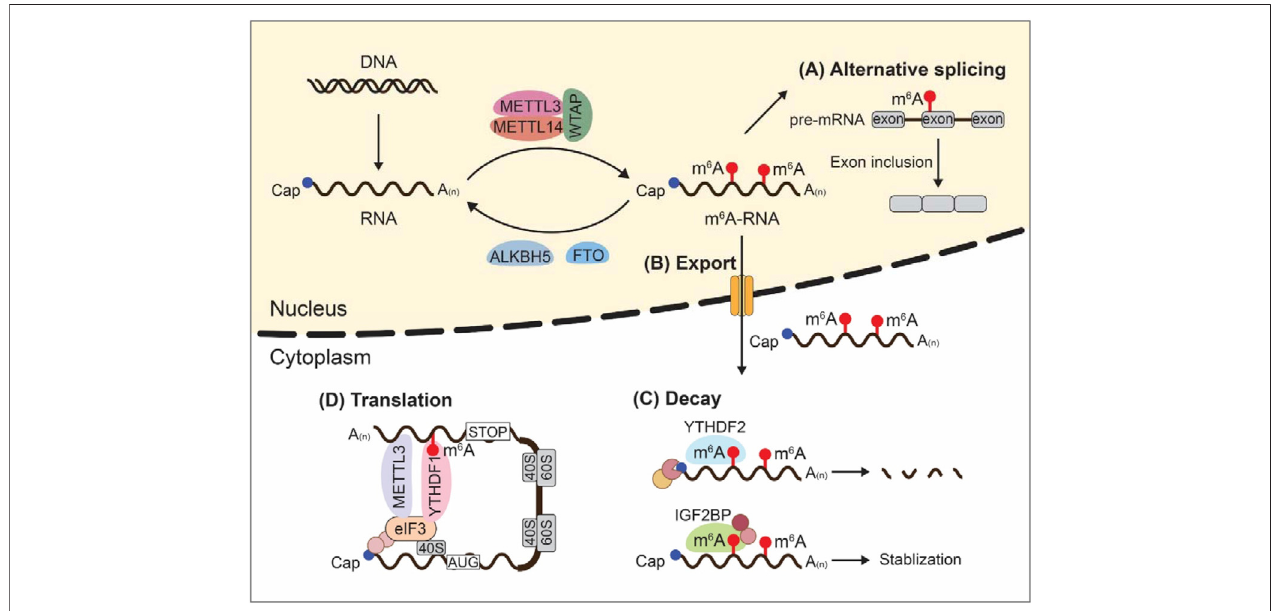
FIGURE 1 | m 6 A modi fi cations and RNA metabolism. Dynamic m 6 A modi fi cations inside cells in fl uence almost every step of RNA metabolism including alternative splicing, intracellular transport, degradation, and translation.